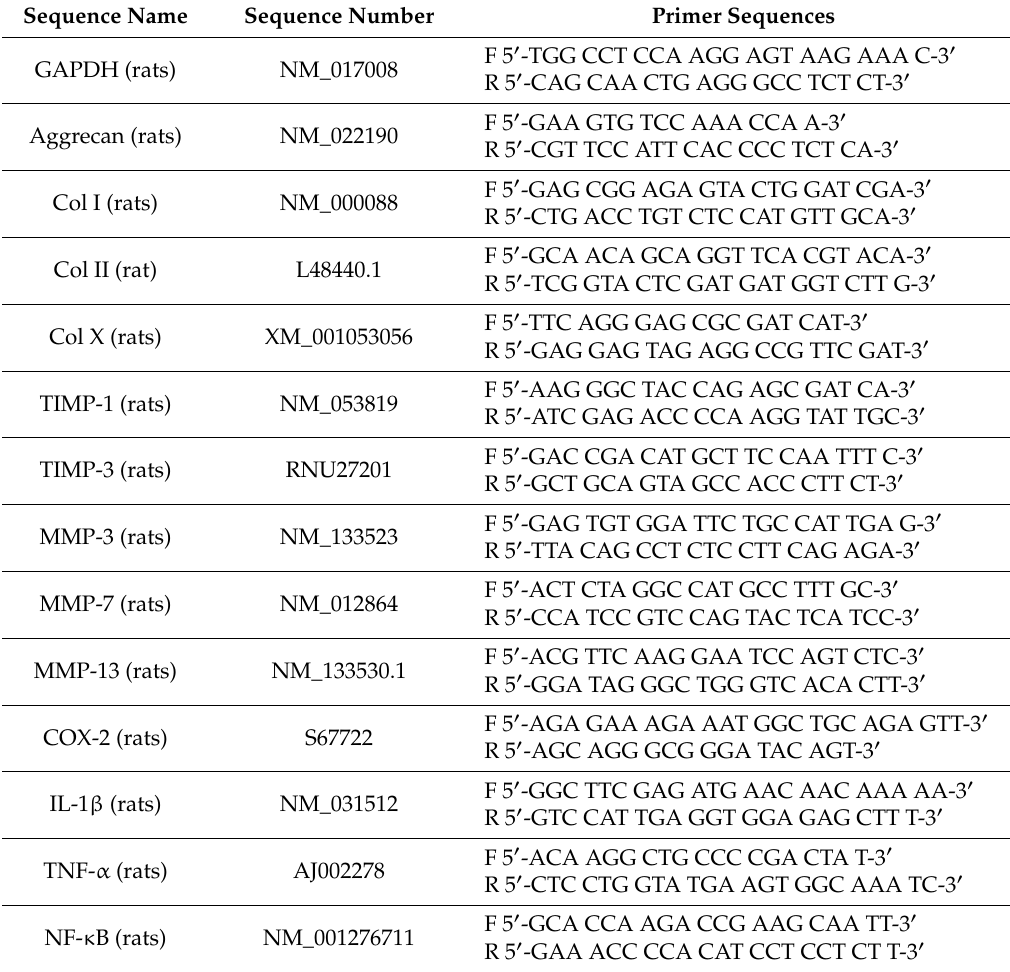
Table 1. Primer set sequence used for Real-Time